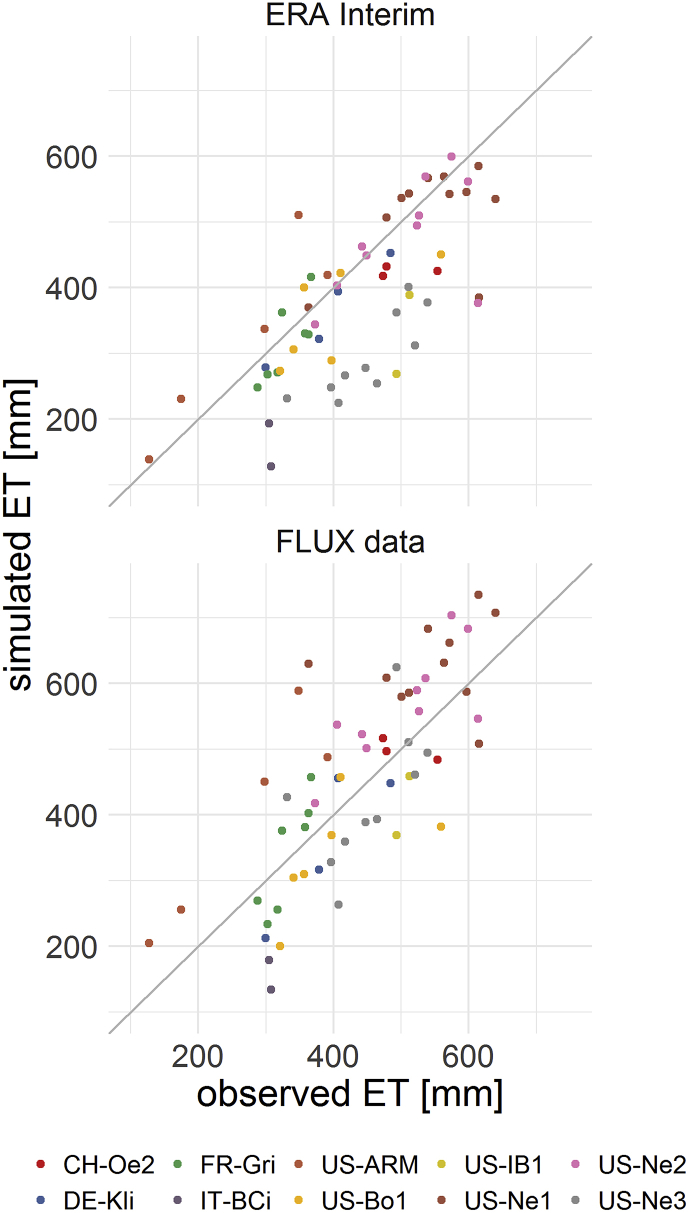
CFTW model results for ETa based on local (FLUX data) and global (ERA Interim) climate data input compared to observations based on eddy covariance measurements.